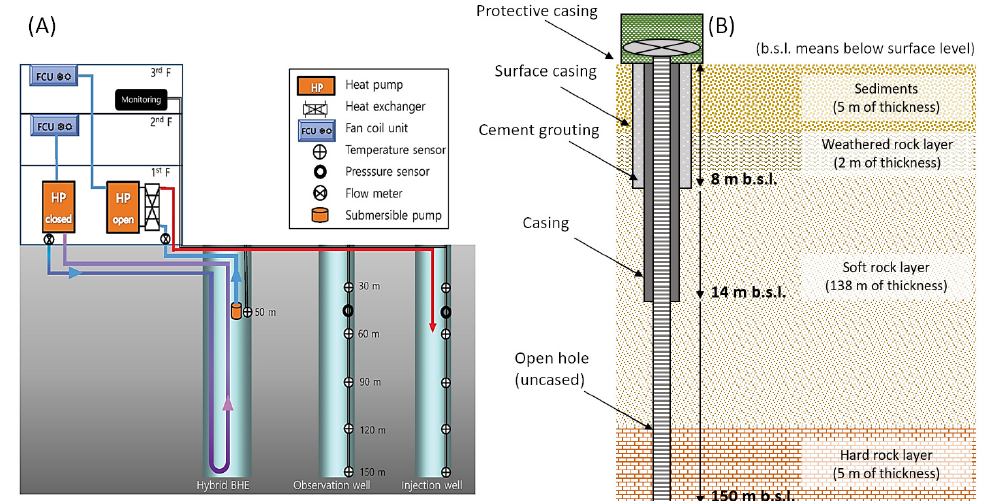
Figure 2. Schematic diagram of a GWHP testbed with a hybrid BHE. The hybrid BHE consists of a BHE including closed and open systems, and the injection well ( A ). The structure and rock properties of the observation well are shown in ( B